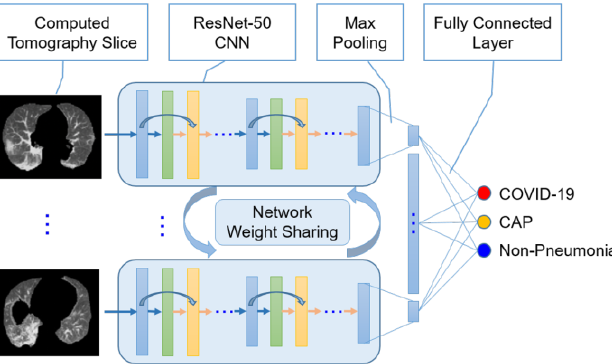
Figure 26. Illustrative architecture of the COVNet model for COVID-19 detection using CT images. Max pooling operation is used to combine features extracted by ResNet-50 CNNs whose inputs are CT slices. The combined features are fed into a fully connected layer to compute probabilities for three classes, i.e., non-pneumonia, community acquired pneumonia, and COVID-19. The predicted class is the one that has highest probability among the three classes [105]. Abbreviations used: ResNet-50, Residual Network with 50 deep layers; CNN, Convolutional Neural Network; COVID-19, Coronavirus disease 2019; and CAP, Community Acquired Pneumonia.